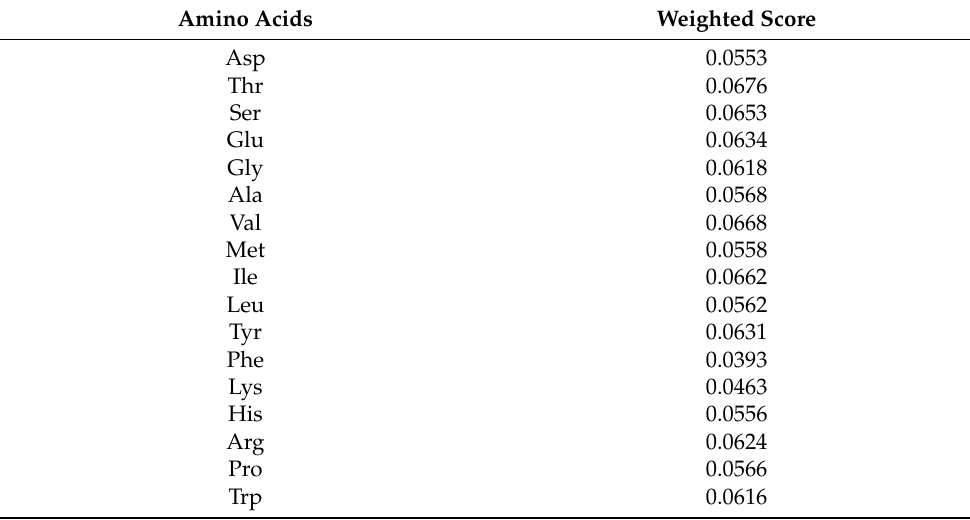
Figure 3. Amino acid principal component analysis rotational load diagram. Table 19. Amino acid factor analysis weight